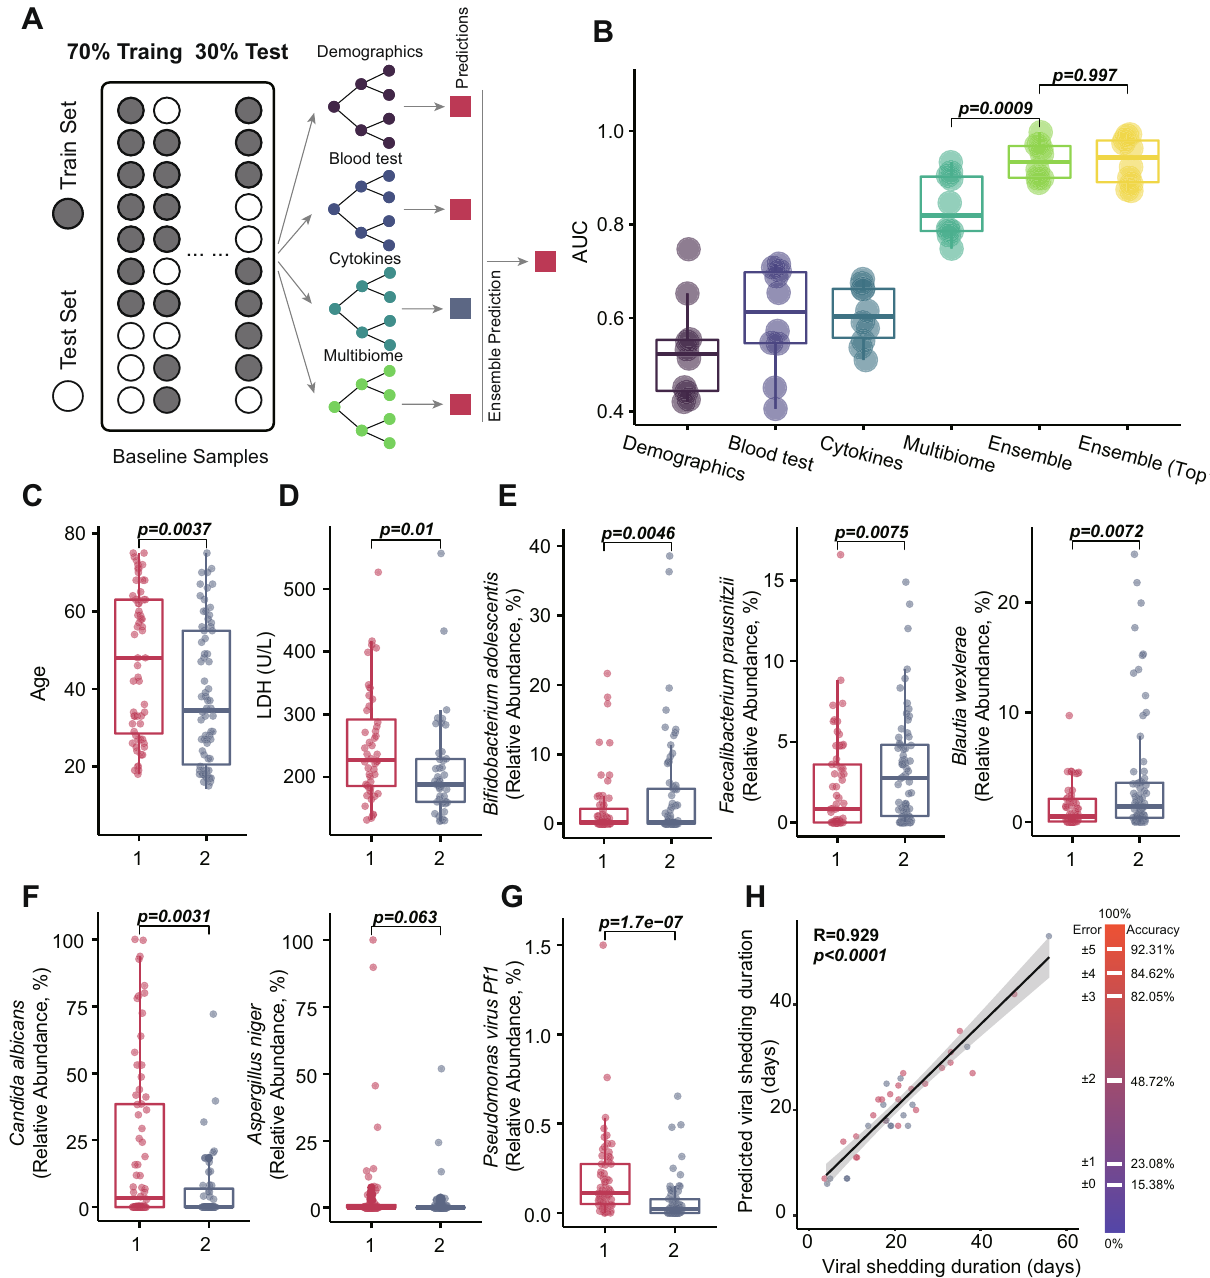
Fig.4|Randomforestclassi fi ermodeltrainedonmulti-biomeandclinicaldata can predict the duration of viral shedding for individual COVID-19 patients. A The input data is a vector with four components: demographics, blood tests, cytokines, and gut multi-biome pro fi les. To estimate model accuracies, a train-test sample split of 70% for training and 30% for testing was utilized. The testing data were then used to estimate the accuracy of the random forest model. B Box-and- whisker plot displaying the distribution of AUC scores for the cross-validation on the training set and the AUC scores for single measurements taken on the test set, obtained by random forest classi fi cation. Differences between groups were eval- uated by the two-sided Wilcoxon rank-sum test. C – G Top features contribute to differentiating clusters (Cluster 1, n =63; Cluster 2, n =70) in the random forest